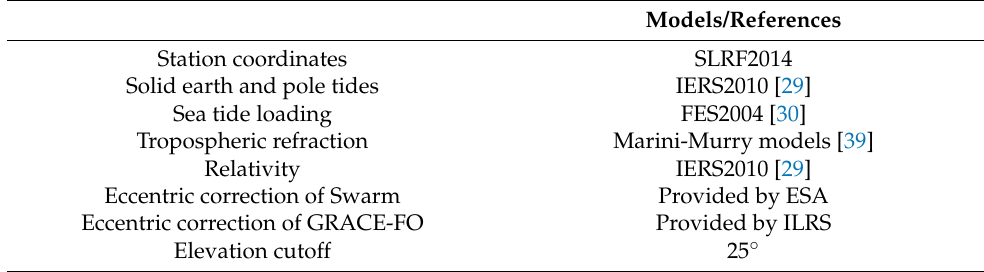
Table 3. SLR data processing